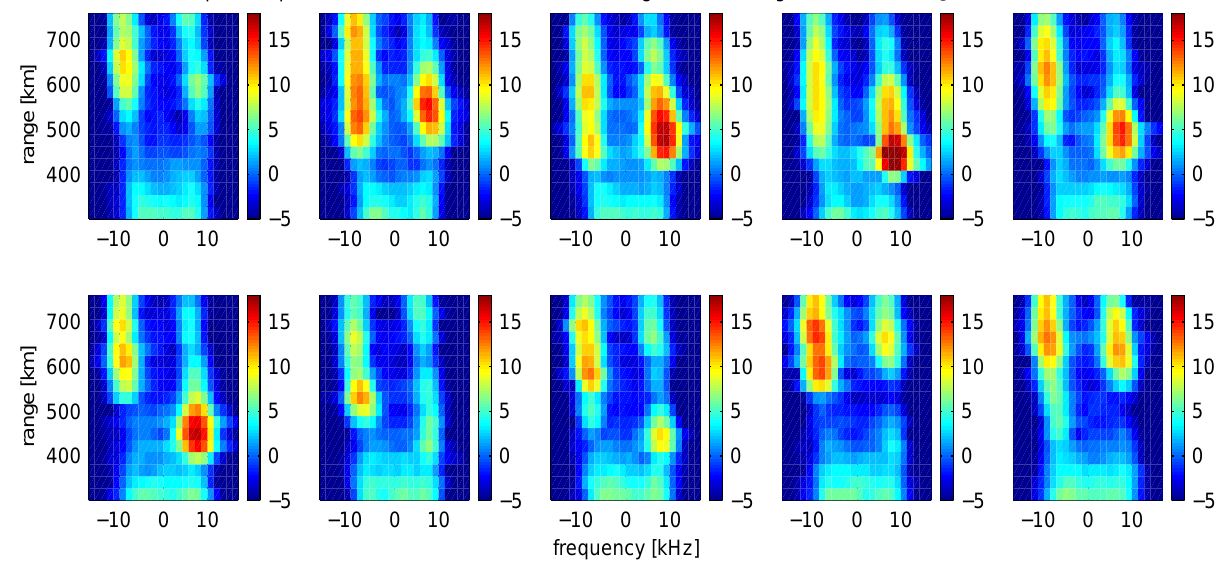
Fig. 9. Example of how an event develops in time. Each panel shows powerspectra from the 42m antenna, in dB, on the same scale for successive 0 . 2s integration periods, 2 seconds total. The background noise has not been subtracted, and range 2 attenuation has not been corrected for. We see for example how one range-frequency region ( + 10kHz at 450km) shows an increase in scattering by 15dB in 0 . 6 seconds, and then fades back to its original value within the next second or so.